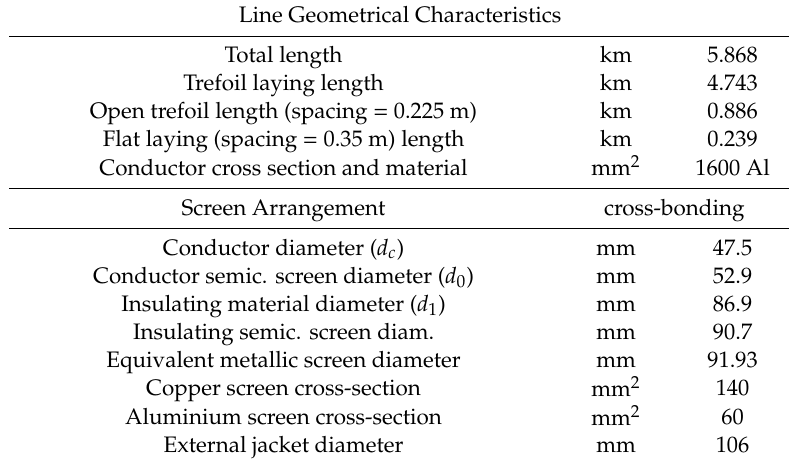
Table 2. Three single-core insulated cables of 132 kV in CP San Giuseppe-CP Portoferraio.